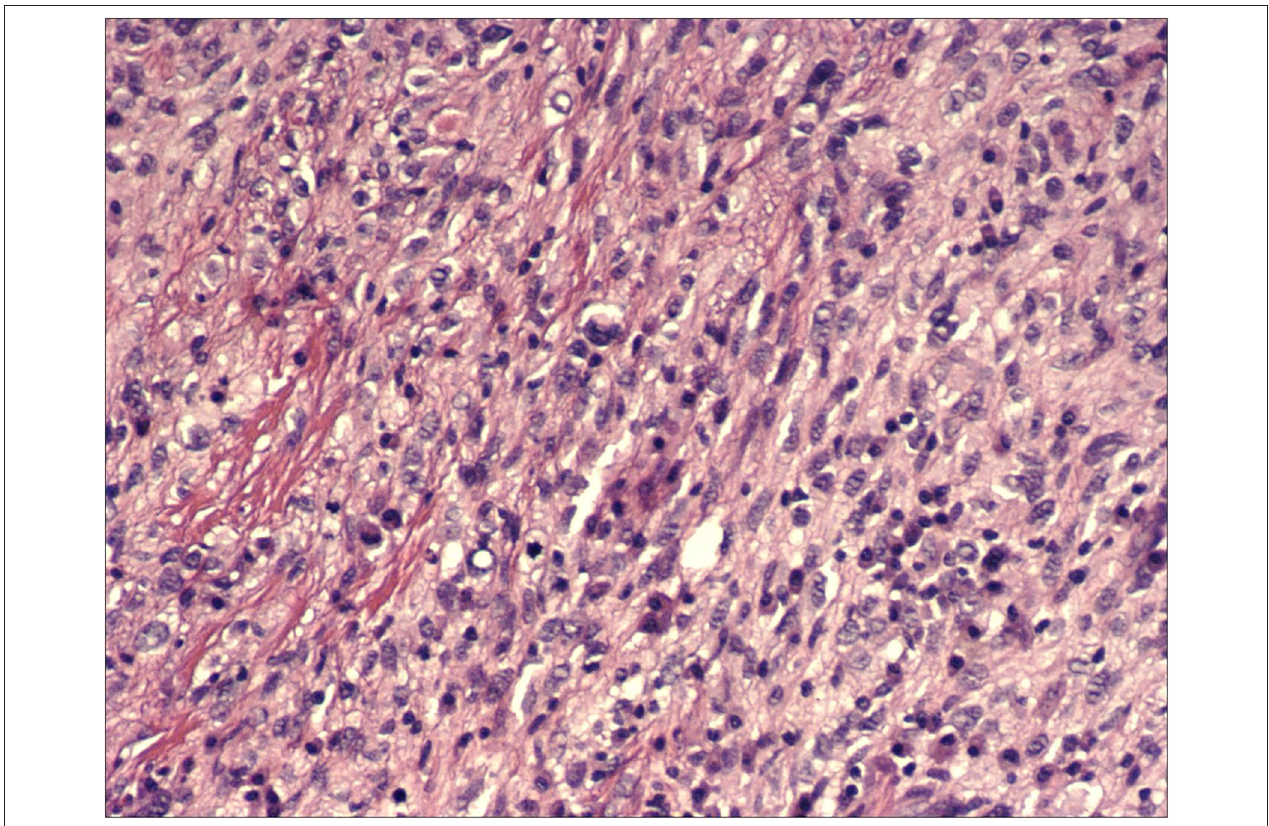
FIGURE 3 | H&E, 200x: hypercellular proliferation composed of spindle cells with nuclear atypia and intermingled moderate amount of inflammatory